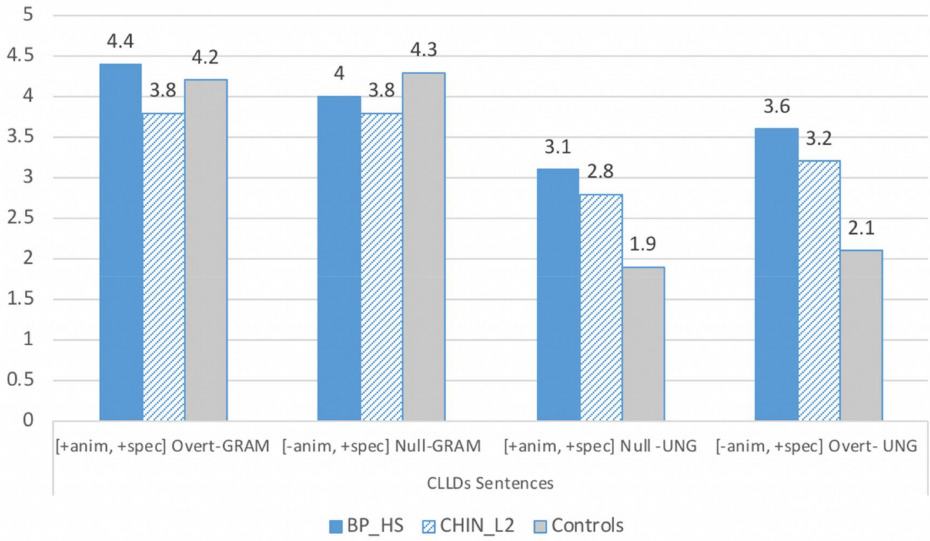
Figure 4. AJT task: proportion of acceptance of grammatical and ungrammatical items in CLLD contexts per